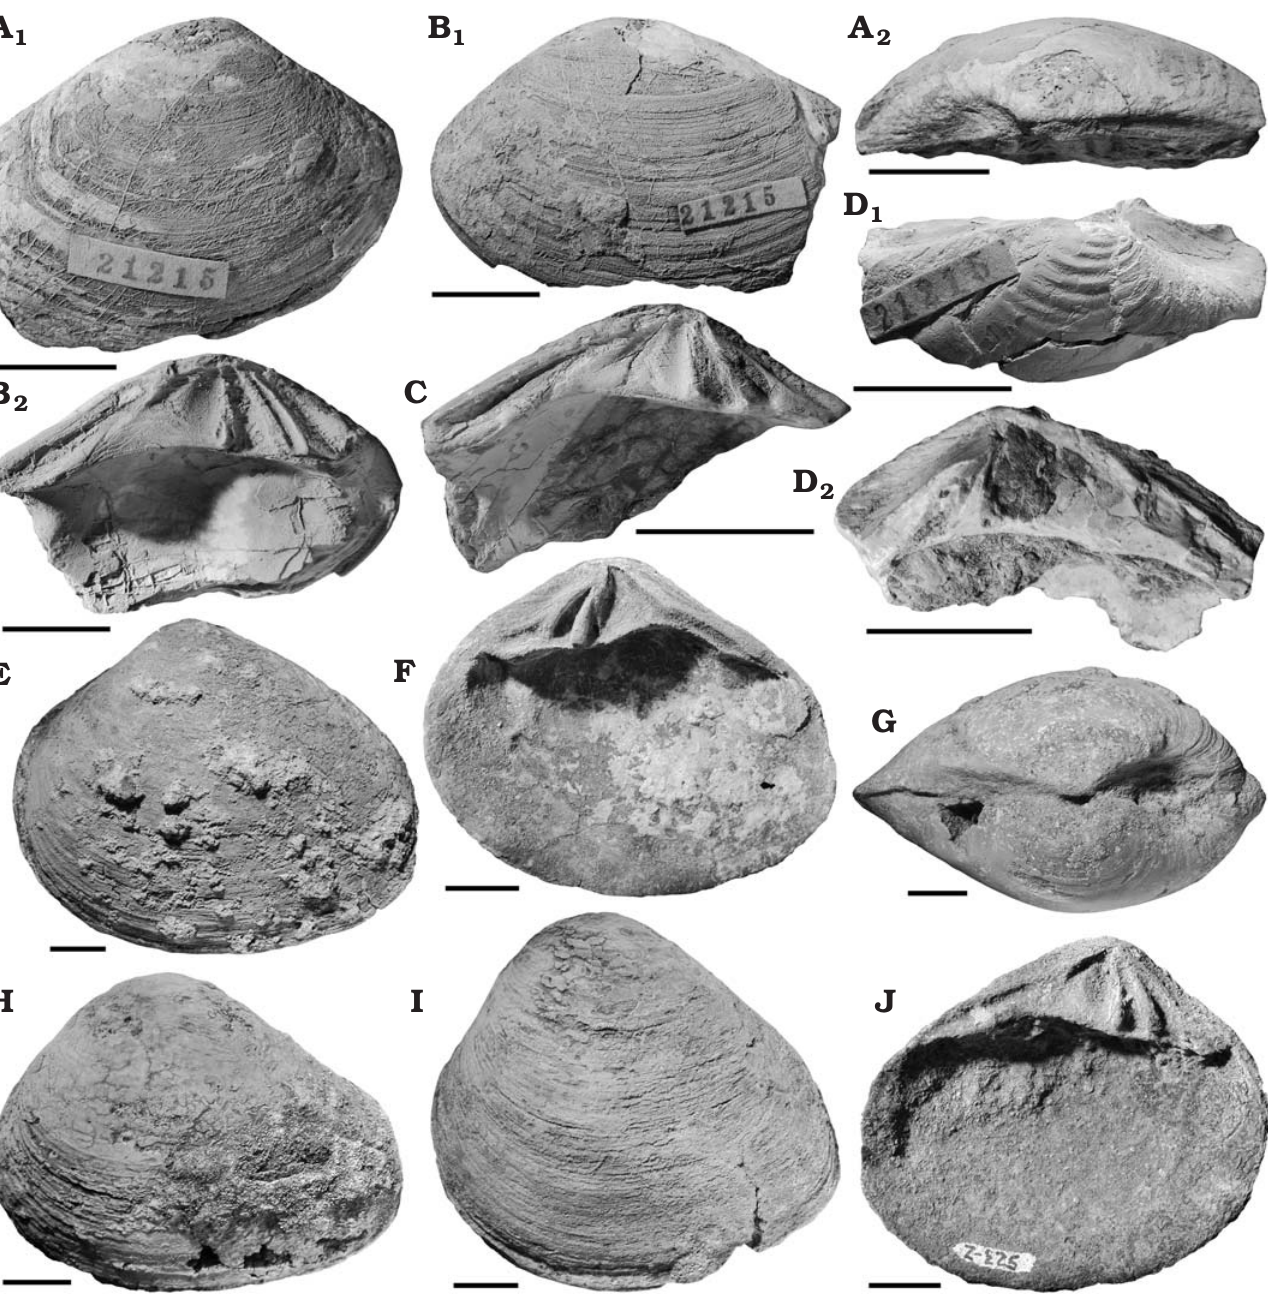
Fig. 9. Veneriform Hybolophus crassatellines from Peru. A − D . Hybolophus disenum sp. nov., late Eocene or Oligocene, Mancora, northern Peru. A . USNM 618239, holotype, exterior (A 1 ) and dorsal margin (A 2 ) of right valve. B . USNM 618238, paratype, exterior (B 1 ) and interior (B 2 ) of left valve. C . USNM 618241, paratype, hinge plate of left valve. D . USNM 618240, paratype, dorsal margin of right valve (D 1 ), anterior at right, hinge plate (D 2 ). E − J . Hybolophus terrestris sp. nov., late Miocene, mid-section in Pisco depositional sequence, south-central Peru. E . UWBM 101874, paratype, exterior of left valve. F . UWBM 101873, paratype, interior of right valve. G . UWBM 101879, dorsal margin of paired valves, anterior at right. H . UWBM 101877, paratype, exterior of posteriorly elongated left valve. I . UWBM 101875, paratype, exterior of left valve with posterior shortening. J . UWBM 101871, holotype, interior of left valve. Scale bars 10 cline. Right anterior pseudocardinal tooth narrow, diverging anteriorly from midpoint of lunule margin. Right cardinal tooth narrow, wedge-shaped, inclined anteriorly 30°. Right posterior pseudocardinal tooth lamellar, diverging 10–20° posteriorly from midpoint of right cardinal tooth, passing resilifer anteriorly. Inner ventral margin smooth.